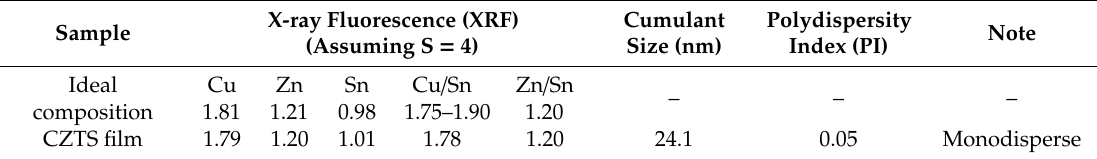
Table 2. Relative concentration of metals (normalized to Cu = 2) and dynamic light scattering (DLS) data on CZTS